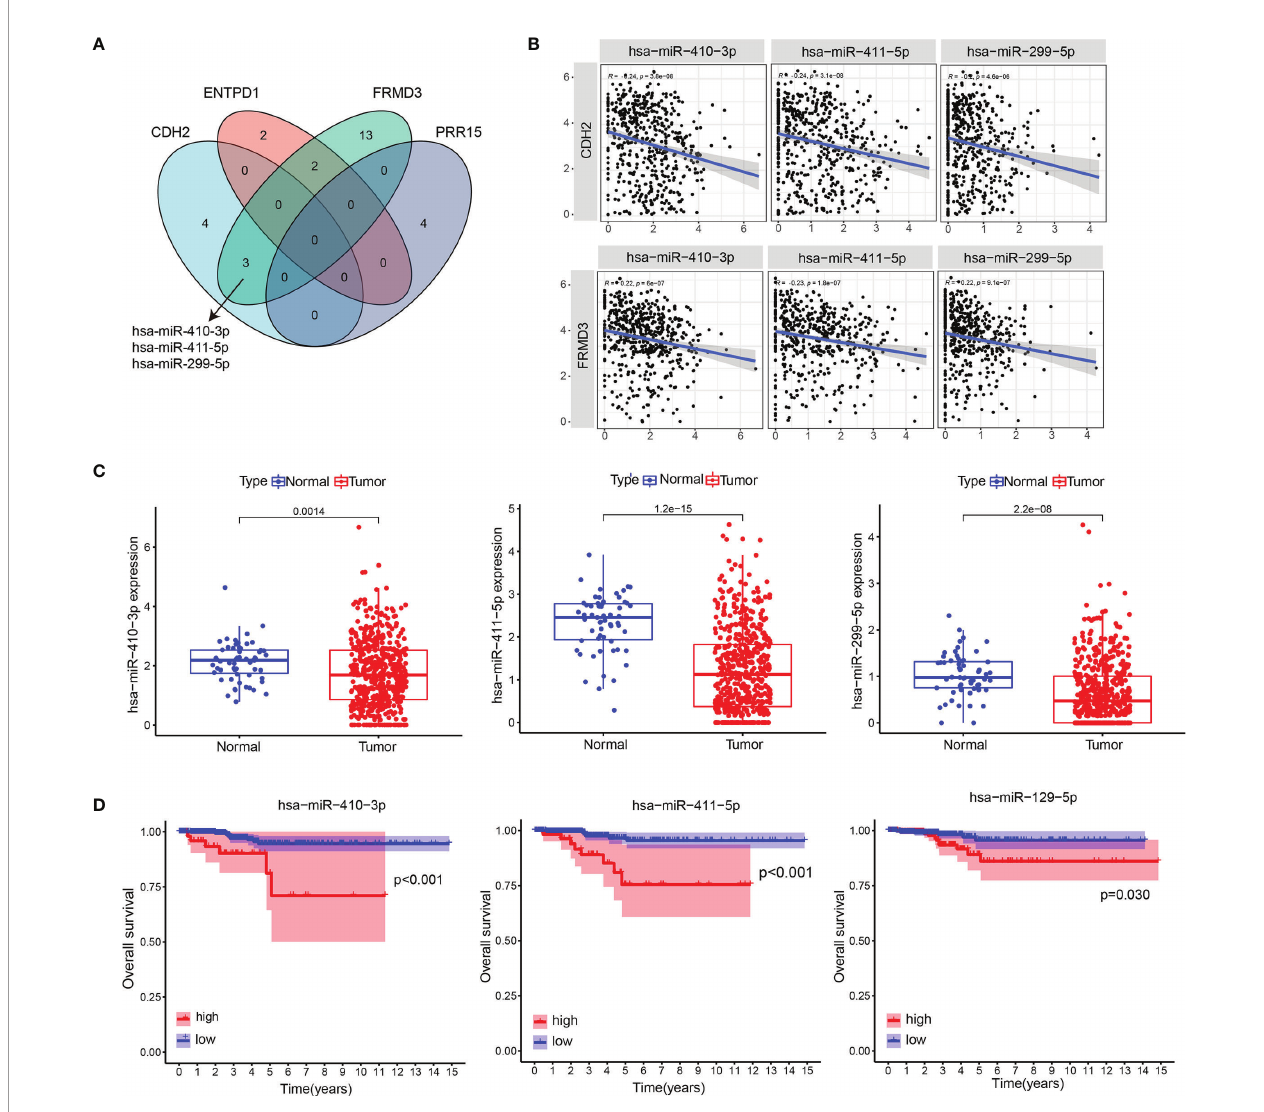
FIGURE 4 | The binding miRNAs of CDH2 and CDH2-related genes. (A) Venn diagram showed the binding miRNAs of CDH2, ENTPD1, FRMD3 and PRR15. (B) The correlations between genes (CDH2, FRMD3) and miRNAs (hsa-miR-410-3p, hsa-miR-411-5p, hsa-miR-299-5p) were performed in TCGA dataset. (C) The levels of hsa-miR- 410-3p, hsa-miR-411-5p and hsa-miR-299-5p in tumor tissues and normal tissues in THCA. (D) The association of hsa-miR-410-3p, hsa-miR-411-5p and hsa-miR-299-5p expression and OS of THCA patients in TCGA